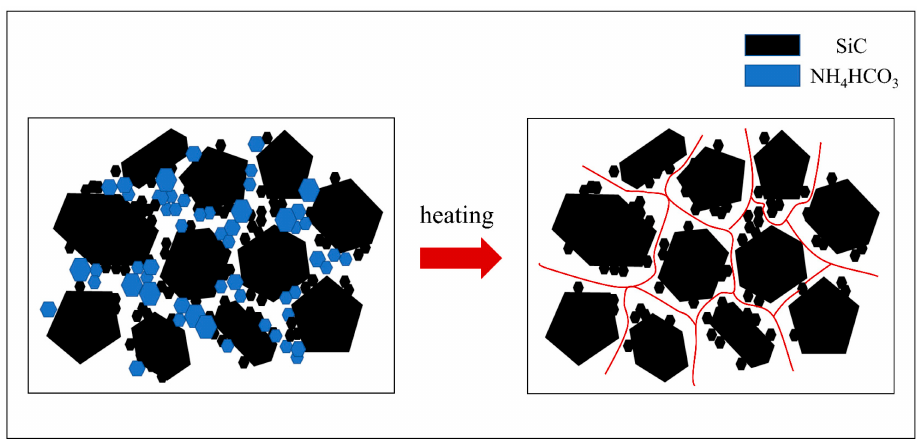
Figure 6. Illustration of the role of NH 4 HCO 3 in the SiC preform.